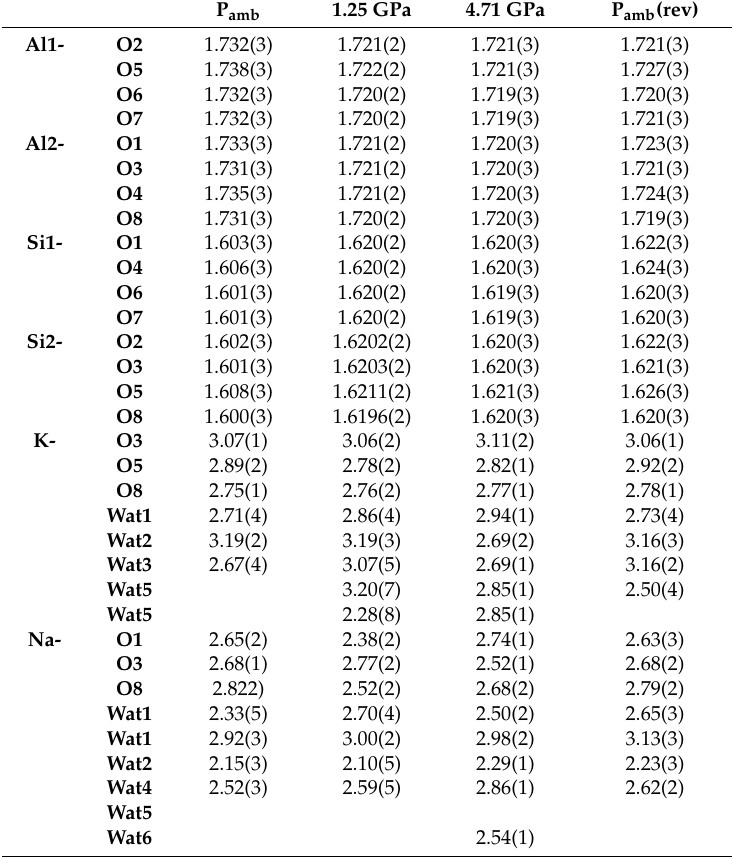
Table 4. Framework and extraframework distances (<3.20 Å) for amicite at P amb , 1.25 GPa, 4.71 GPa, and upon decompression (P amb (rev)) in